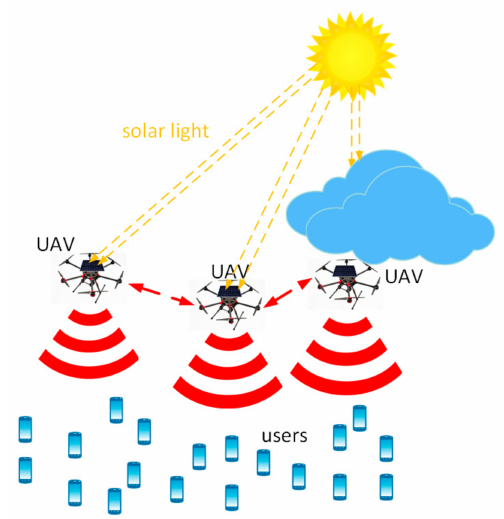
Figure 1. Network